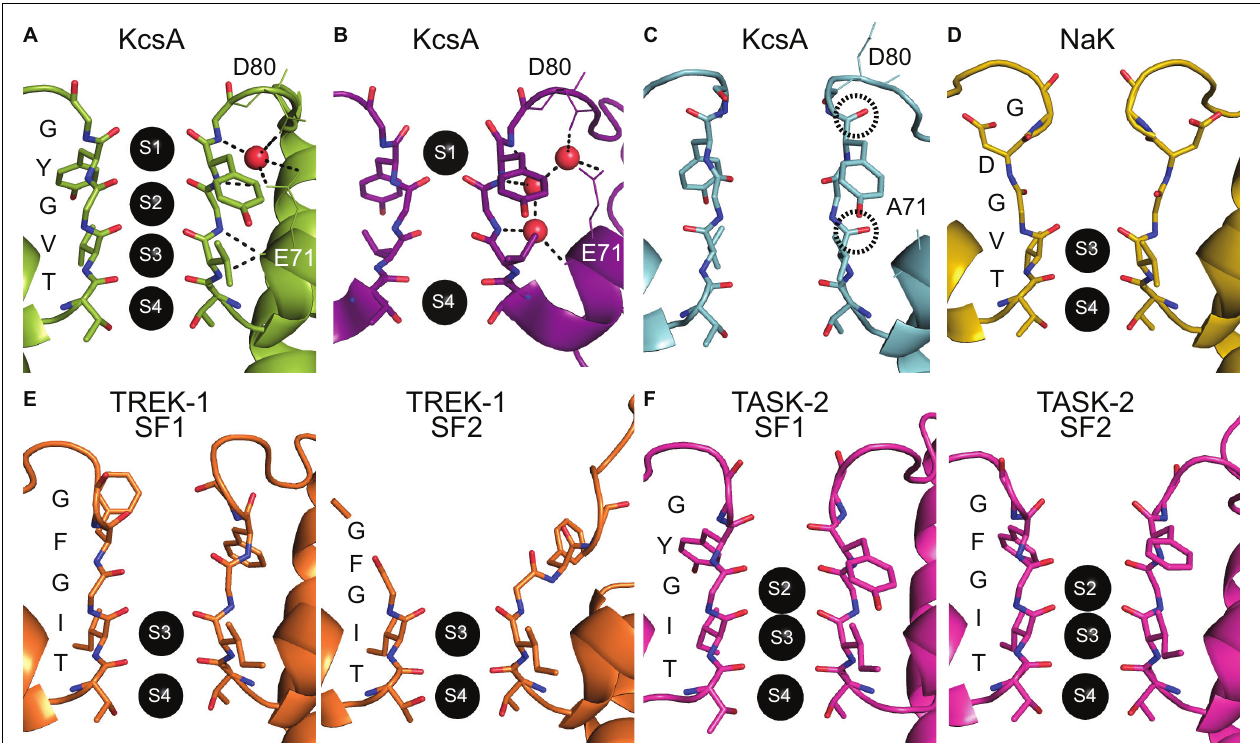
FIGURE 1 | Atomic structures of selectivity filter conformations. (A) The conductive conformation of the SF of KcsA (PDB ID: 1K4C) with two opposing subunits depicted and with the sequence and ion binding sites indicated. (B) The collapsed SF conformation of KcsA under low potassium conditions (PDB ID: 1K4D). (C) The flipped SF conformation of the E71A KcsA mutant (PDB ID: 2ATK) with the reoriented backbone carbonyl groups of the SF circled. Residues D80 and E71 are indicated and depicted as lines. The hydrogen bond network is symbolized with black dashed lines and water molecules are depicted as red spheres in one of the two opposing subunits. (D) The crystal conformation of the SF of NaK (PDB ID: 3E86). (E) The asymmetric SF conformations of TREK-1 under low potassium conditions (PDB ID: 6W7C) with the opposing subunit pairs of SF1 and SF2 shown. (F) The asymmetric SF conformations of TASK-2 at pH 6.5 (PDB ID: 6WLV) with the opposing subunit pairs of SF1 and SF2